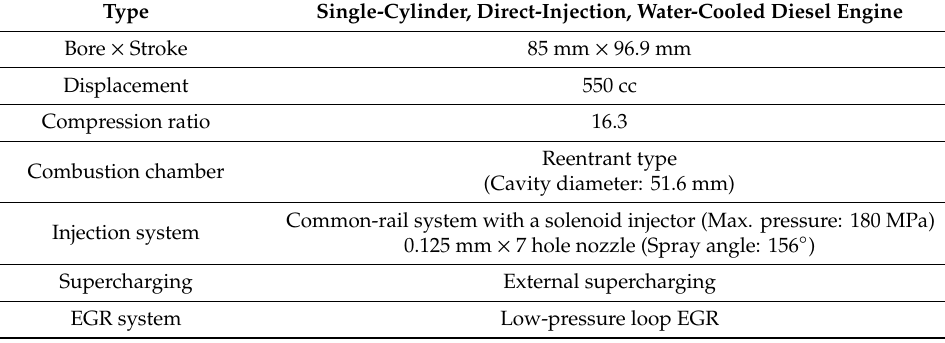
Figure 1. Experimental setup. Table 1. Specifications of the test engine.